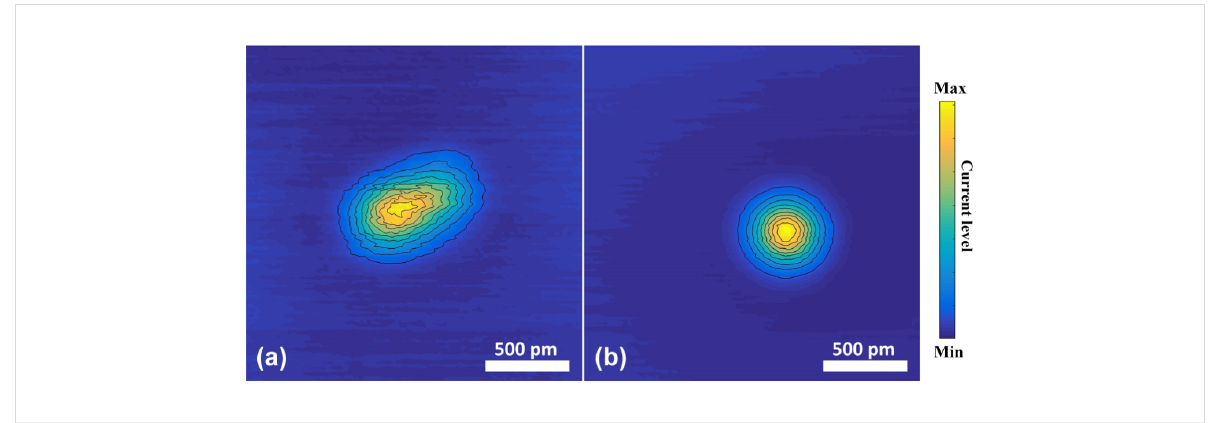
Figure 4: Normalized constant-height images starting from another initial tip apex (a) evolving towards a symmetric apex at the end of the procedure (b). The contours shown are linearly spaced in current. For ease of comparison the current levels in the images have been normalized to the maximum current level which for the above figures are 38 and 24 nA, respectively